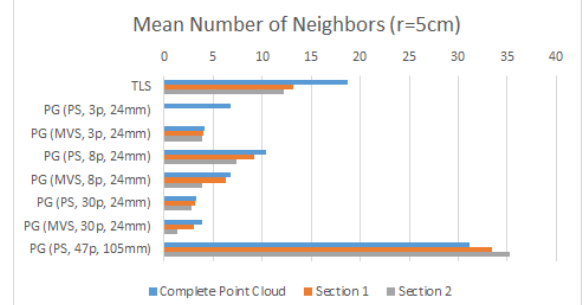
Figure 7. Mean number of neighbours within a sphere of 5 cm of radius for a zone of the rockfall for different acquisition and processing configurations TLS: Terrestrial Laser Scanning, PG: Photogrammetry, PS: Agisoft Meteshape, MVS: OpenMVS.